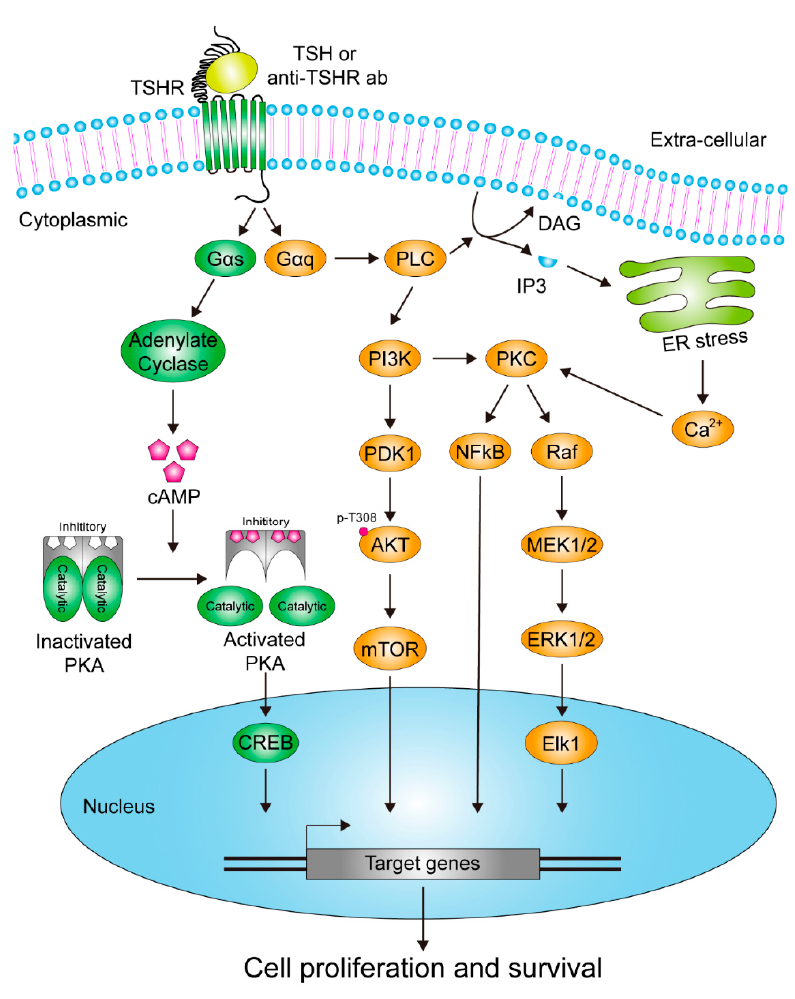
Figure 2. Diagrammatic representation of the identified signaling pathways activated by TSHR in thyrocytes.